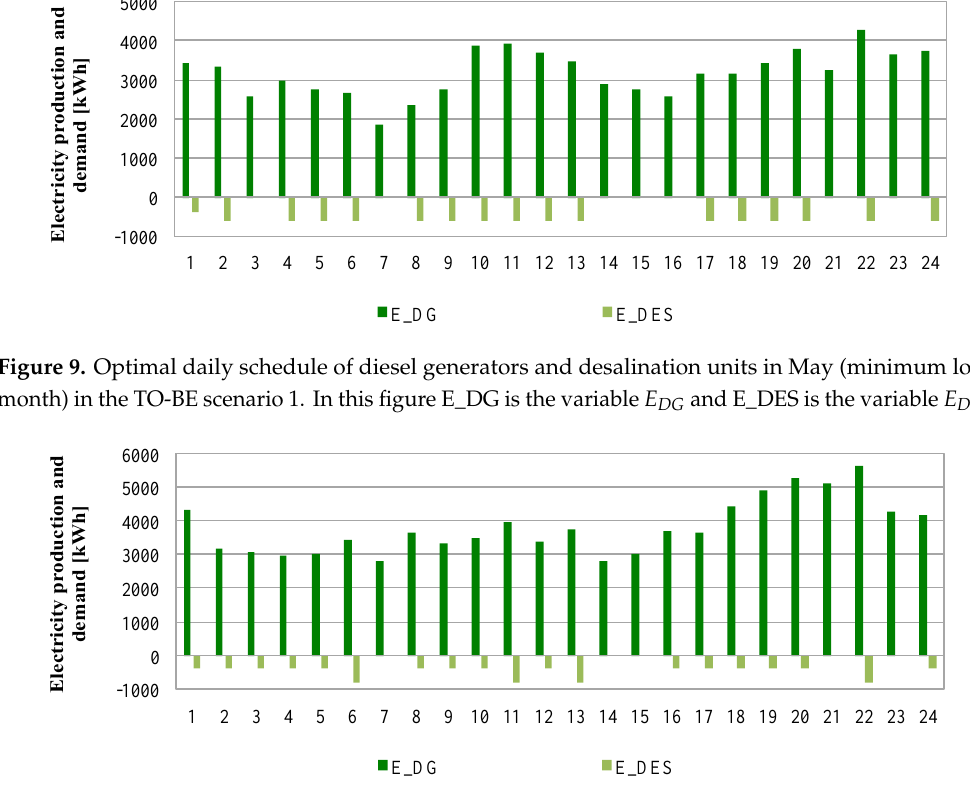
Figure 10. Optimal daily schedule of diesel generators and desalination units in January (average load month) in the TO-BE scenario 1. In this figure E_DG is the variable E DG and E_DES is the variable E DES.